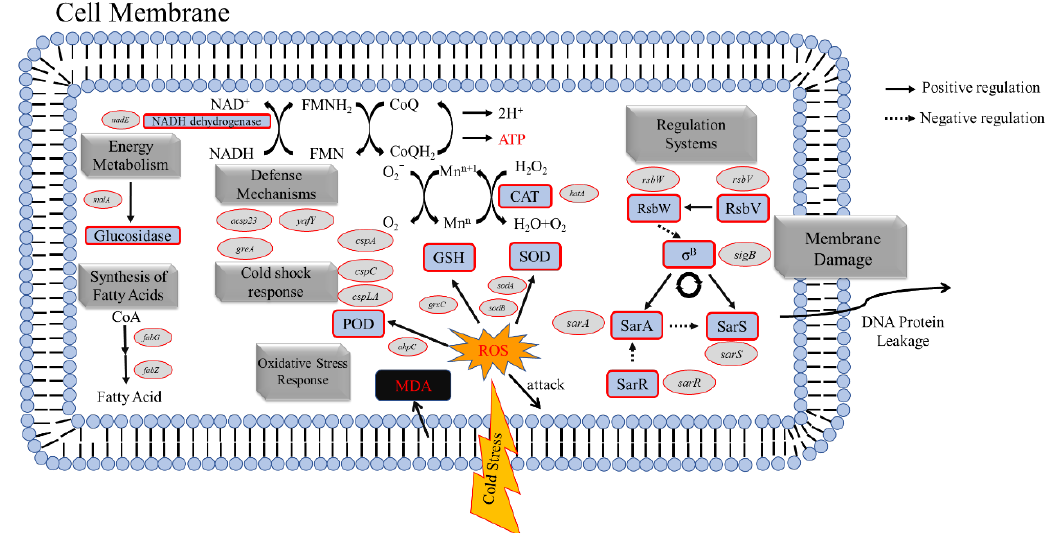
Figure 10. The response of S. aureus to a low temperature in vivo includes a cell structure response, oxidative stress response, energy metabolism response, regulation systems, and defense mechanisms. The oval box represents the DEGs, and the dotted arrows represent the various responses that are detrimental to the organism. Arrows indicated the activation, while the blunt-end arrows represented repression.